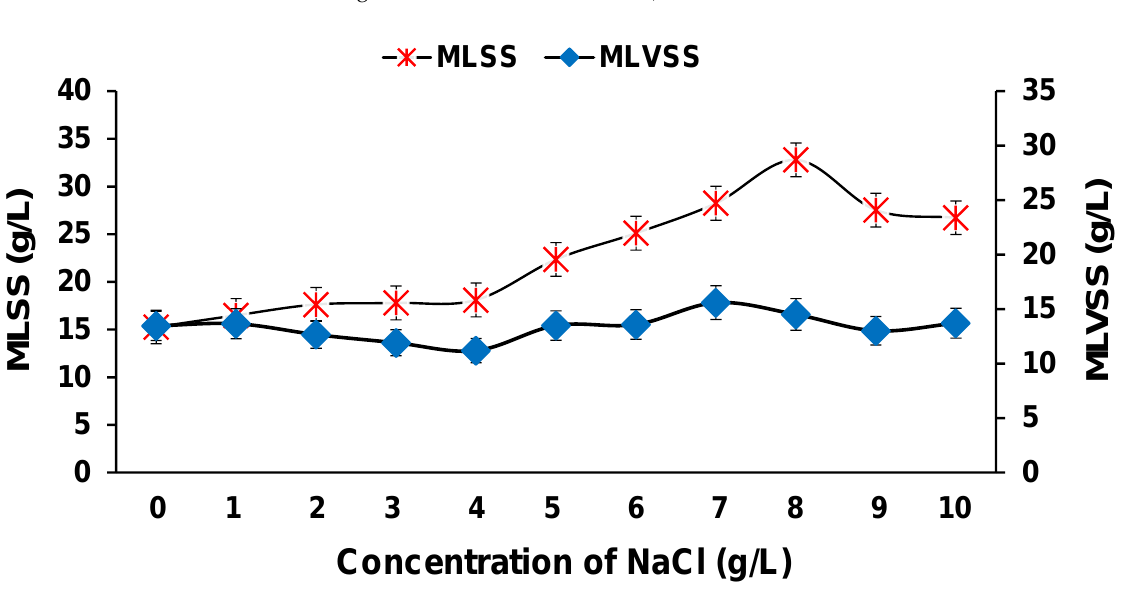
Figure 11. Effect of salinity on MLSS and MLVSS.